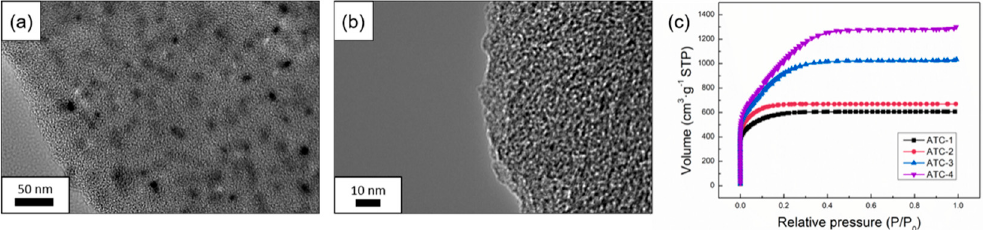
Figure 2. ( a , b ) TEM image of ATC-3; ( c ) N 2 adsorption/desorption isotherms of ATC-1/2/3/4 at 77 K.